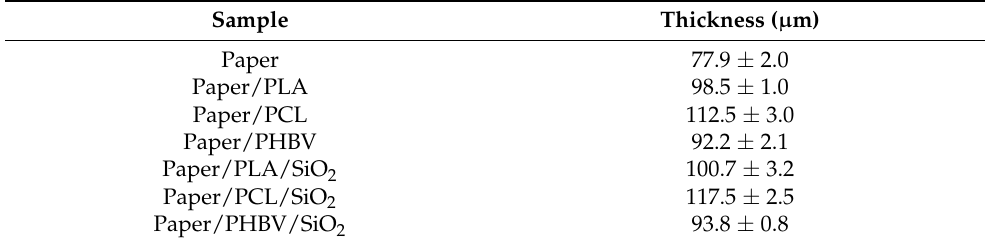
Table 3. Thickness of the multilayer structures based on paper, electrospun polylactide (PLA), poly( ε -caprolactone) (PCL), and poly(3-hydroxybutyrate-co-3-hydroxy-valerate) (PHBV) mats, and electrosprayed hydrophobic silica